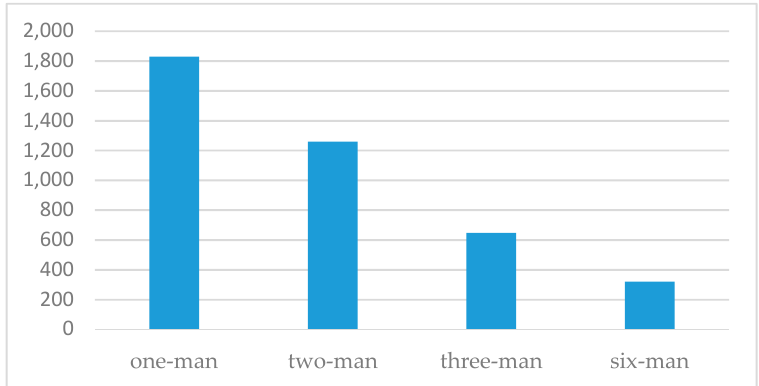
Figure 21. Mean times with different numbers of participants under the experimental conditions (horizontal axis: number of participants; vertical axis unit: seconds).